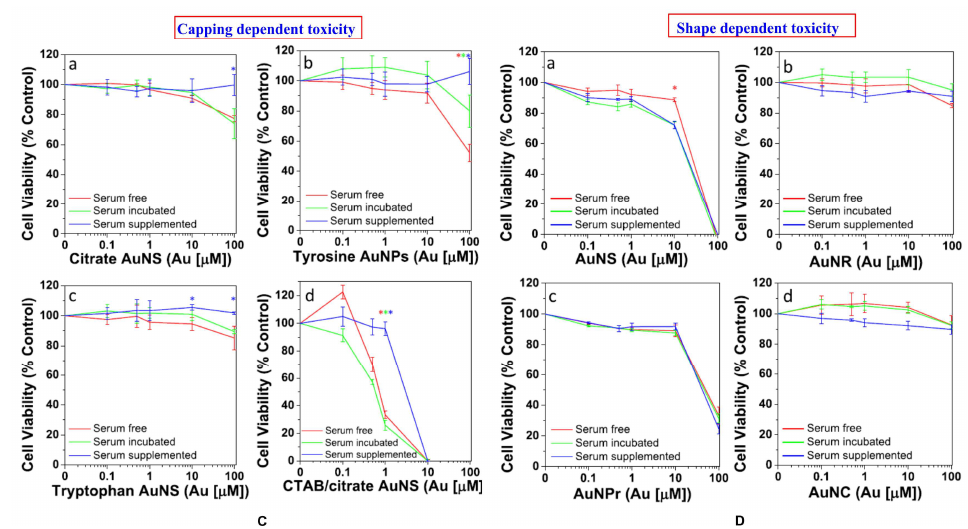
Figure 3. ( A ) Representation of different cappings (CTAB, citrate, tryptophan, and tyrosine) used in synthesizing gold nanostructures of different shapes. ( B ) TEM images of ( a ) CTAB capped gold nanosphere, ( b ) CTAB capped gold nanocube, ( c ) CTAB capped gold nanorods, ( d ) CTAB capped gold nanoprism, ( e ) CTAB and citrate capped gold nanosphere, ( f ) citrate capped gold nanosphere, ( g ) tryptophan capped gold nanosphere, and ( h ) tyrosine capped gold nanosphere. ( C ) Cell viability was measured for gold nanosphere (AuNS) with various cappings: ( a ) citrate, ( b ) tyrosine, ( c ) tryptophan, and ( d ) CTAB and citrate in prostate cancer cells (PC3). ( D ) Cell viability was measured for different shapes of gold nanostructures capped via CTAB: ( a ) Gold nanosphere (AuNS), ( b ) gold nanorods (AuNR), ( c ) gold nanoprisms (AuNPr), and ( d ) gold nanocube (AuNC). Adapted from the ref. [137] with permission. Copyright@American Chemical Society. Asteriks indicate significant differences ( p < 0.05) between different conditions at the same dose